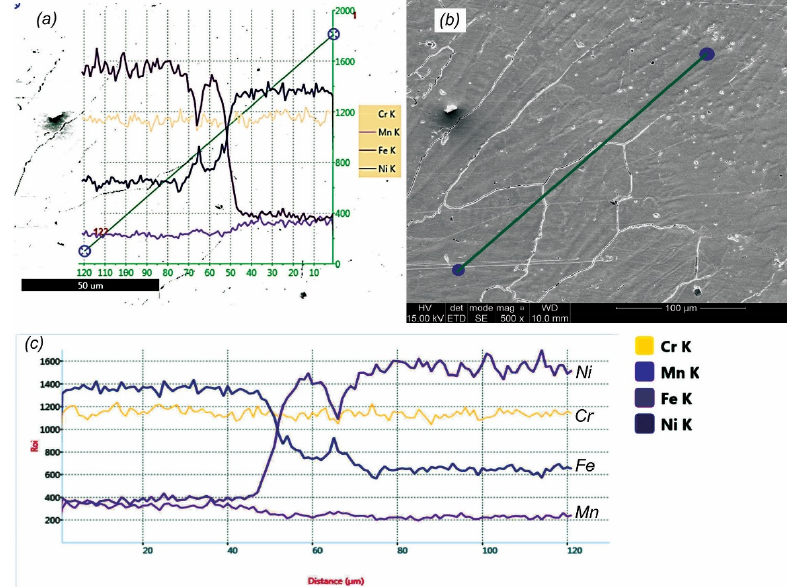
Figure 13. Results of EDS linear analysis for the zone: Incoloy 800HT nickel alloy ( a ) distribution of elements against the background of the structure with the measuring line marked; ( b ) microstructure of the weld area–HAZ–Incoloy 800HT nickel alloy with the line according to which the elements were measured; ( c ) linear distribution of elements. Metals 2020 , 10 , 559